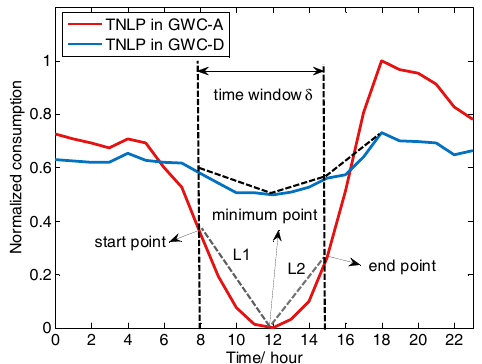
Figure 5. Illustration of the third feature.